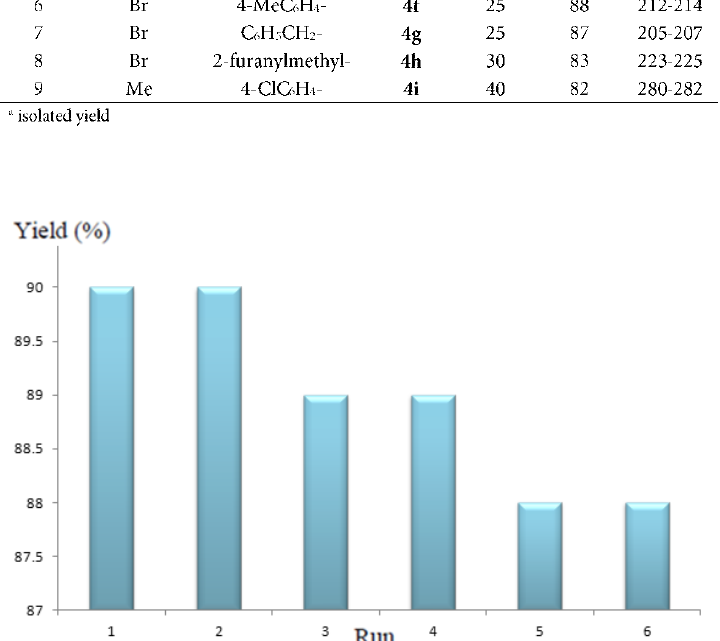
O /NiO@GQDs @SO 3 4